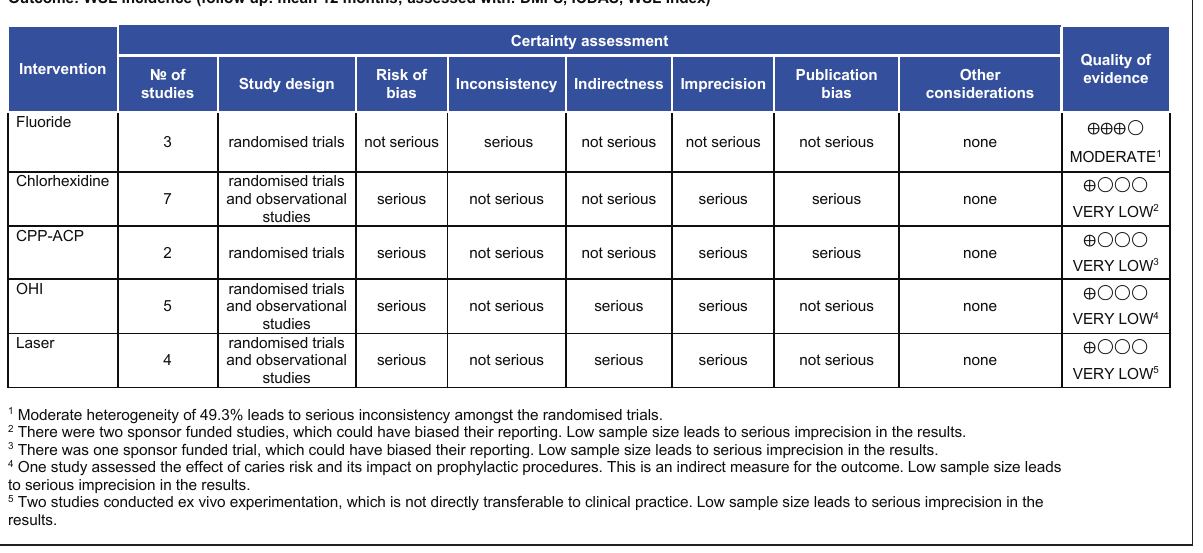
Figure 5. GRADE evidence profile: caries prevention during orthodontic